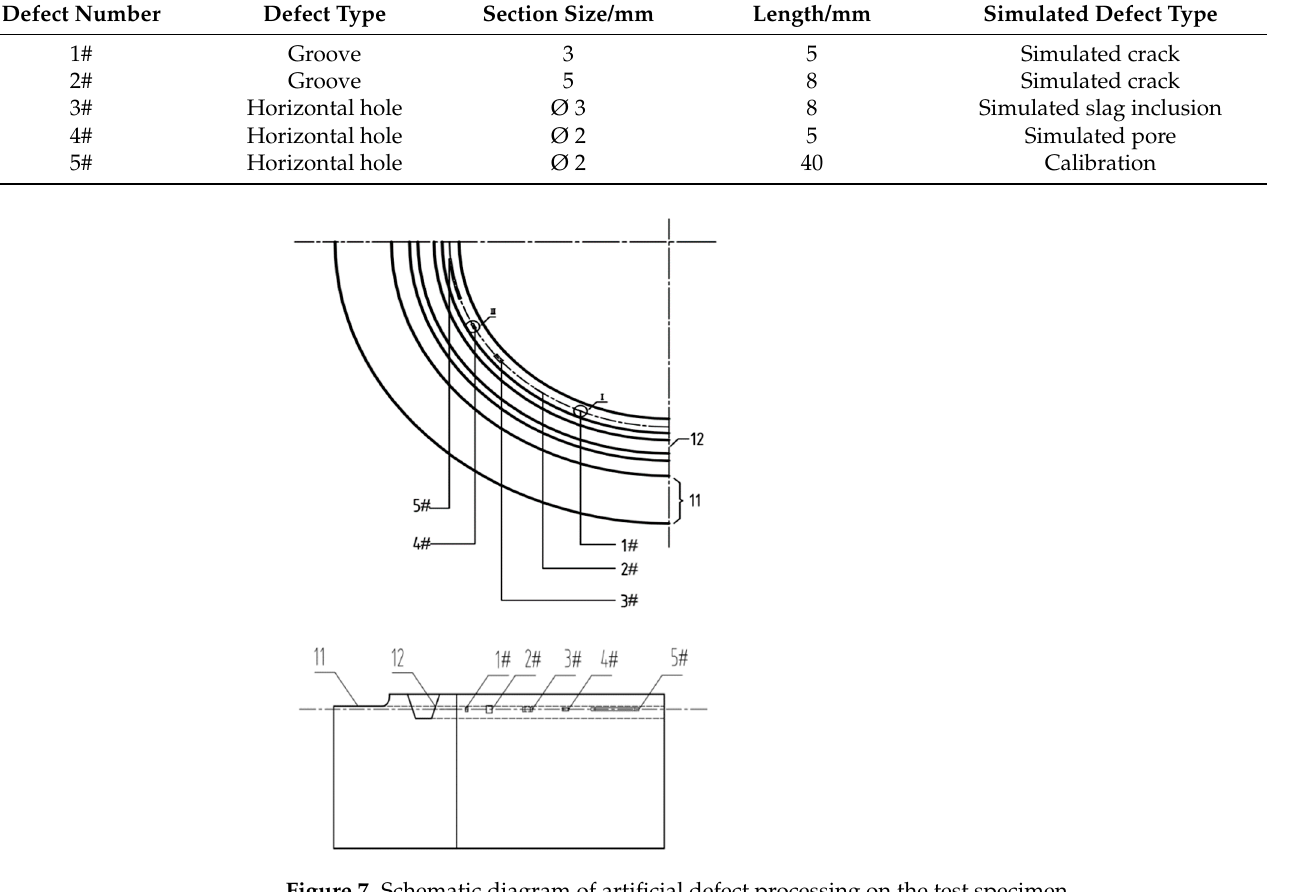
Figure 7. Schematic diagram of artificial defect processing on the test specimen.